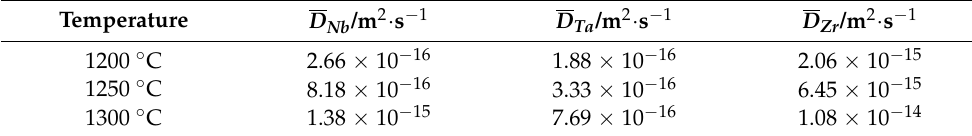
Table 2. Average interdiffusion coefficient of Nb D Nb , Ta D Ta and Zr D Zr in γ -Ti-54Al.